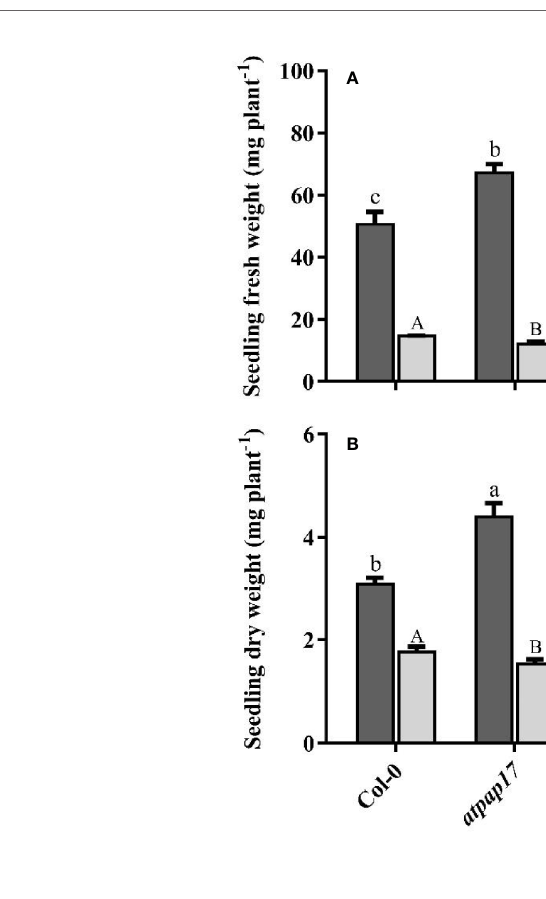
FIGURE 3 | Seedling fresh weight (A) and dry weight (B) of Col-0, AtPAP17 and AtPAP26 mutants ( atpap17 , atpap26 , and atpap17 / atpap26 ). Plants grown for 7 days under +Pi (1.25 mM KH 2 PO 4 ) then transferred to +Pi (1.25 mM KH 2 PO 4 ) and − Pi (no Pi) conditions for 14 days as described in the materials and methods. Values are the means ± SE of three biological replicates. Signi fi cant differences are indicated by different letters above the bars ( P <